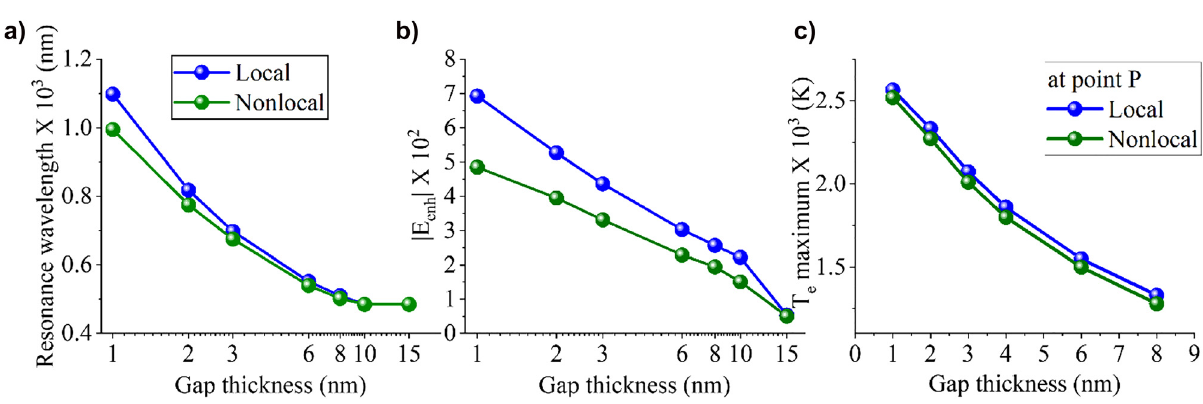
Figure 3: Local and nonlocal calculations of (a) absorption resonance wavelengths (computed by Figure 2(a)), (b) maximum electric fi eld enhancements, and (c) maximum electron temperatures. All these results are plotted versus the nanogap thickness. The induced maximum electron temperature values are calculated at point P depicted in the inset of Figure